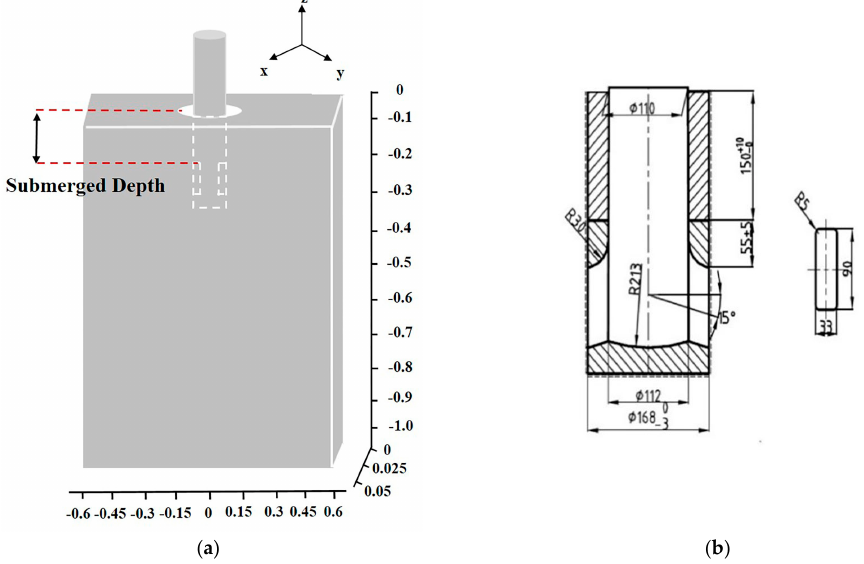
Figure 3. Schematic of mold water model: ( a ) mold size and ( b ) submerged entrance nozzle size.